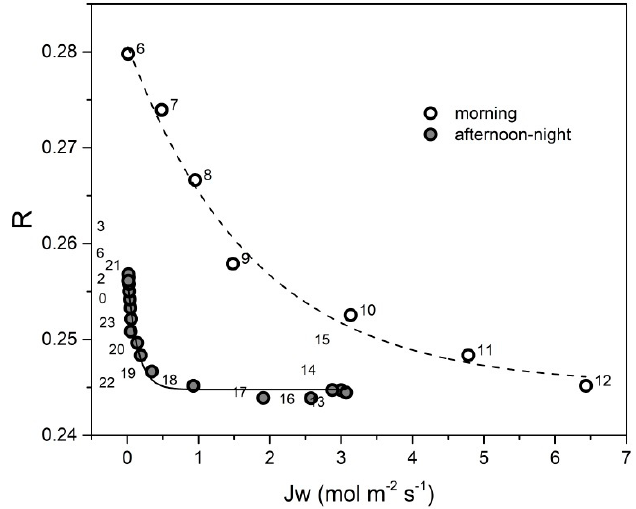
Figure 4. Example of the influence of Jw on the diurnal variation of R recorded during ( ○ ) “morn- ing” and (•) “afternoon–night”. Labels indicate the hour of the day, note that 1–5 h refer to the following day.